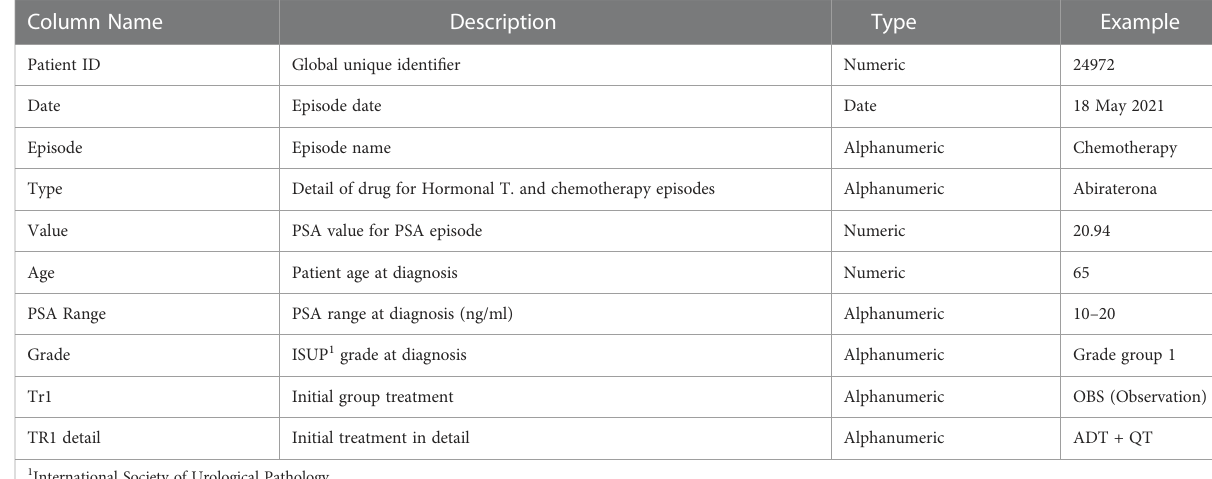
TABLE 1 Data description: Episodes and